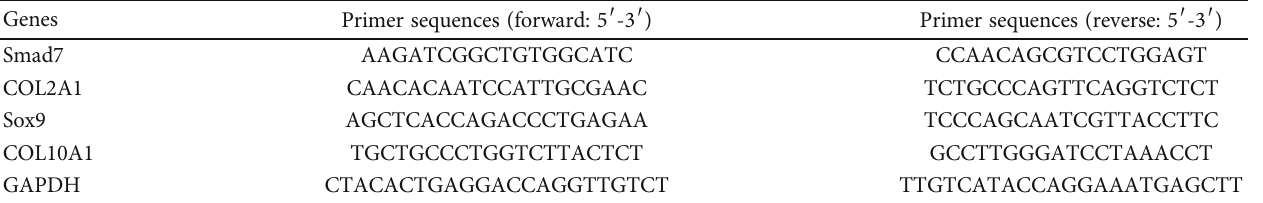
Table 1: The primer sequences used for qRT-PCR. Genes Primer sequences (forward: 5 ′ -3 ′ ) Primer sequences (reverse: 5 ′ -3 ′